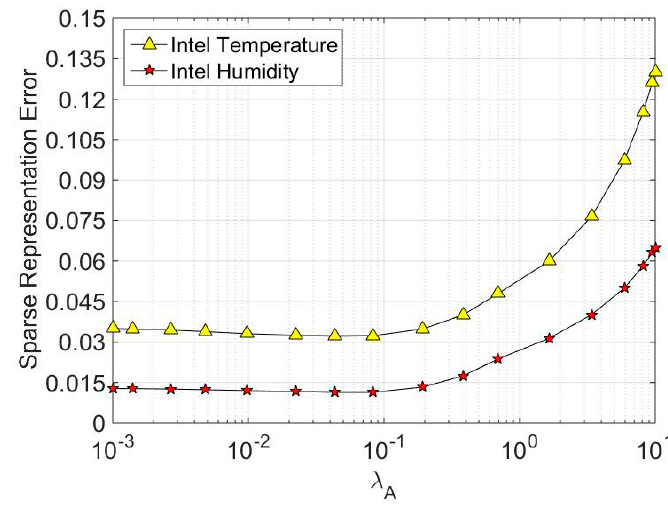
Figure 3. The impact of sparse coefficient regularization parameter λ A on sparse representation error.